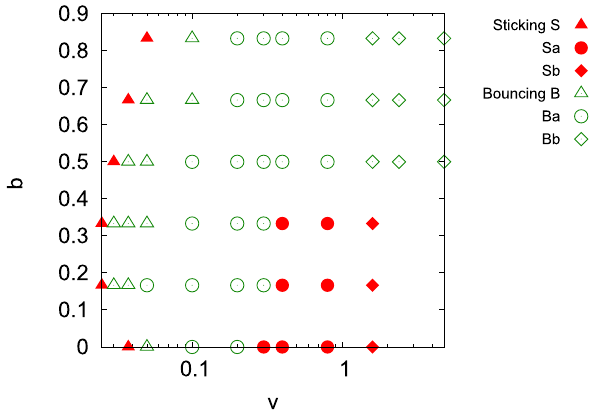
Figure 3. Classification of NP collisions into sticking and bouncing in dependence of collision velocity v and impact parameter b . Filled symbols: sticking collisions (S), with Sa: sticking and flattening, and Sb: sticking and strong deformation (shearing, fragmentation). Open symbols: bouncing collisions (B), with Ba bouncing and flattening, and Bb: bouncing and strong deformation (sliding, fragmentation). Note the logarithmic abscissa